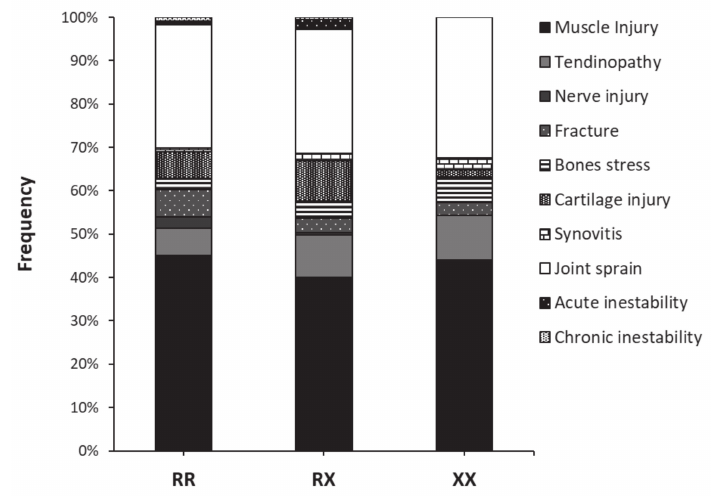
Figure 2. Distribution of non-contact injuries according to their type in women football players of the first division of Spanish football with different ACTN3 R577X